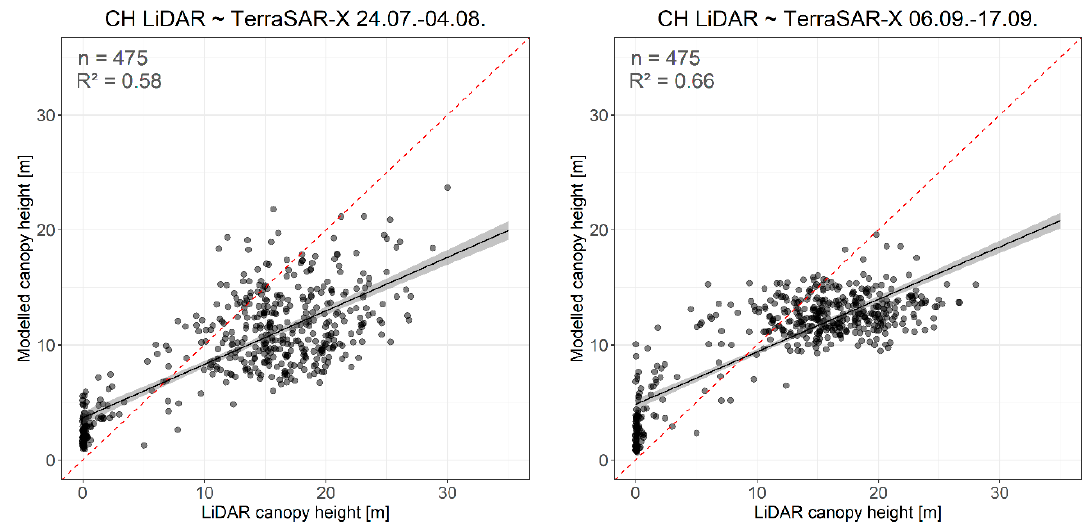
Figure 6. Correlation of reference LiDAR canopy height and modelled TS-X canopy height using RMoG model based on an interferogram from 24.07.–04.08. (left) and 06.09.–17.09. (right). Red dashed line = 1:1 line; black line = linear trend including confidence bounds.